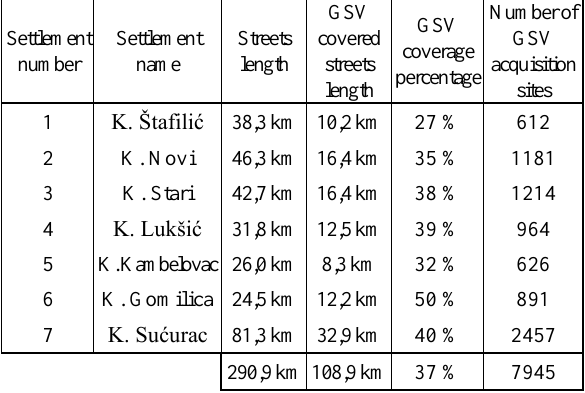
Table 2. Streets lengths, GSV covered streets lengths, GSV